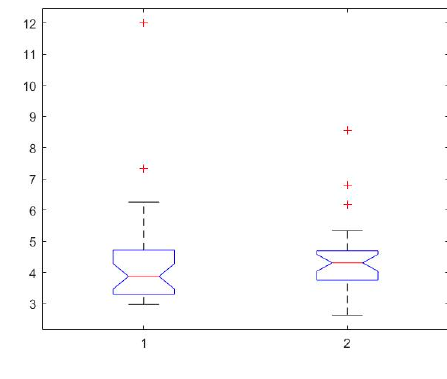
1. MAPE indicator. The result indicates a similarity between the MAPE values.